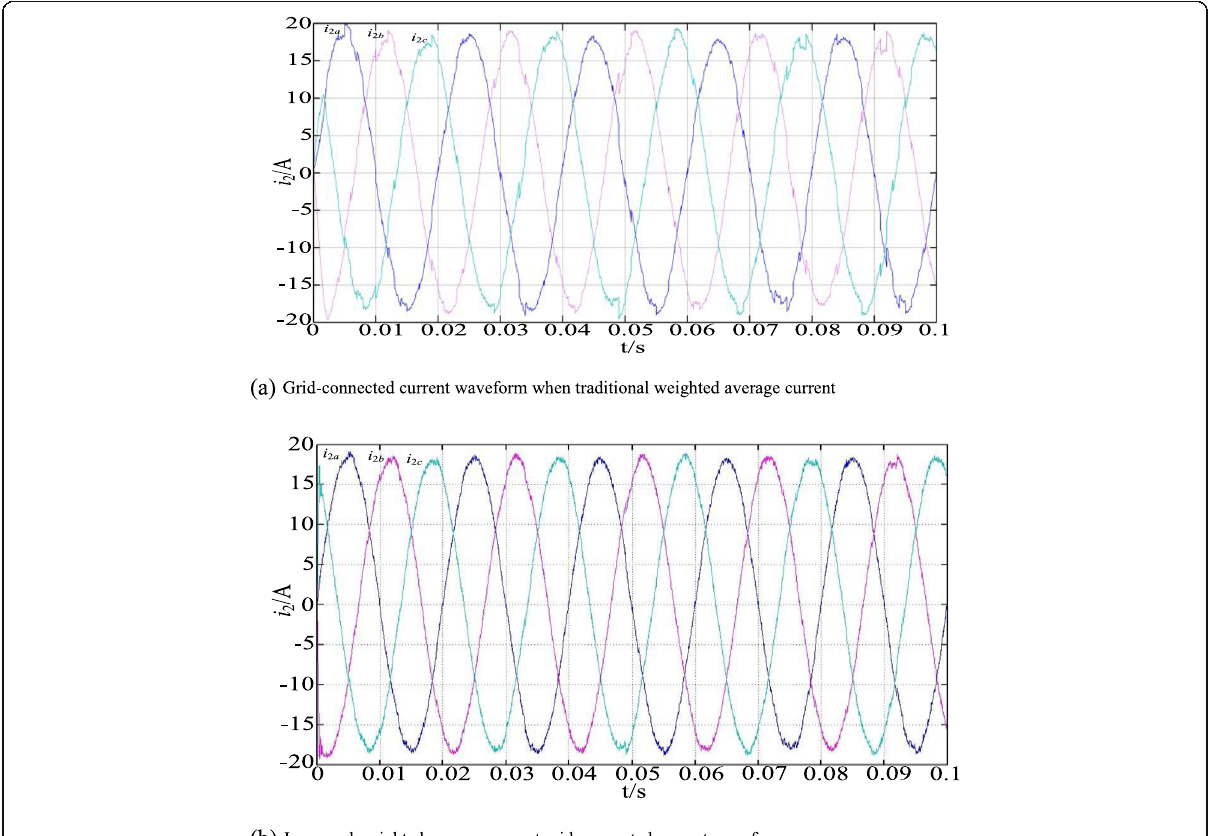
Fig. 11 Grid-connected current waveform at Lg = 0.6 mH. a Grid-connected current waveform when traditional weighted average current. b Improved weighted average current grid-connected current